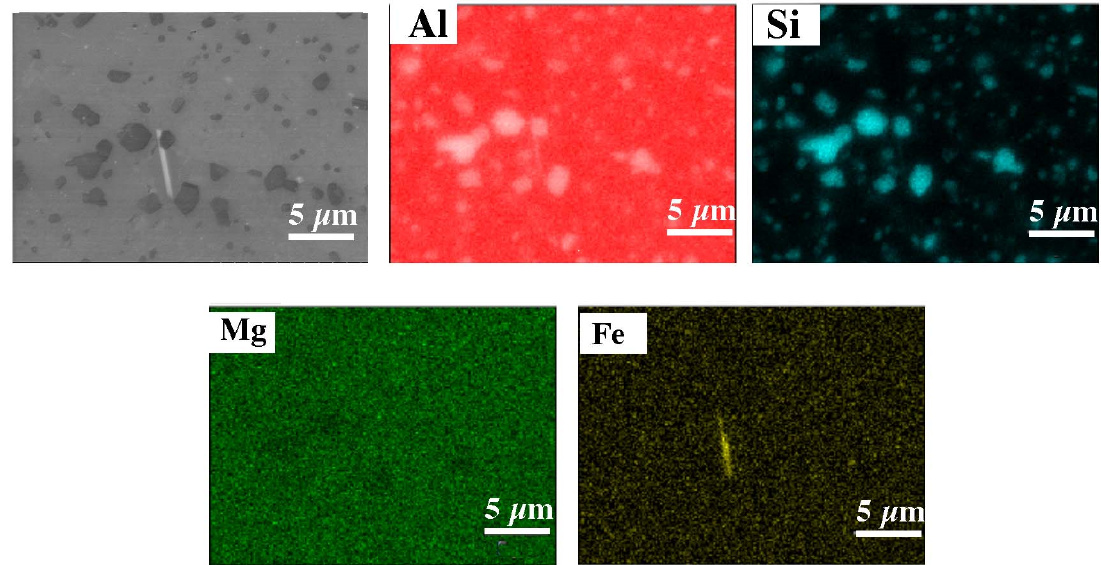
Figure 15. Map of the distribution of elements for the sample after supersaturation and 16 h ageing (EDS).